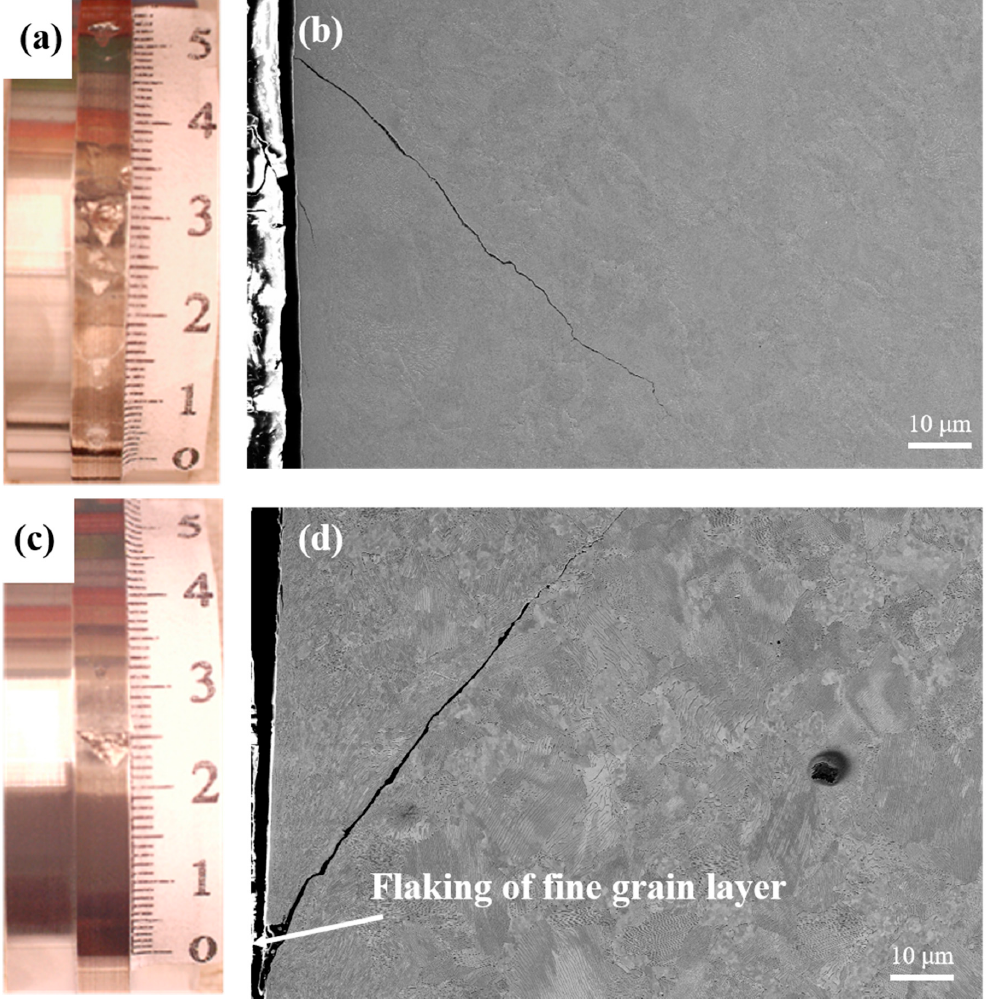
Figure 12. Surface morphology and RCF cracks: ( a , b ) the grinding processing sample and ( c , d ) the sample after SURT with 0.4 MPa.